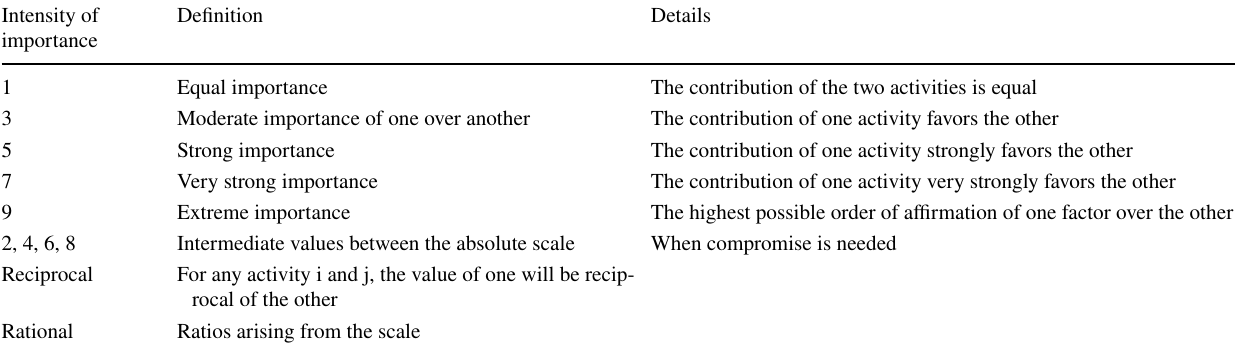
Table 3 The fundamental scale for AHP (Saaty, 1980) Intensity of